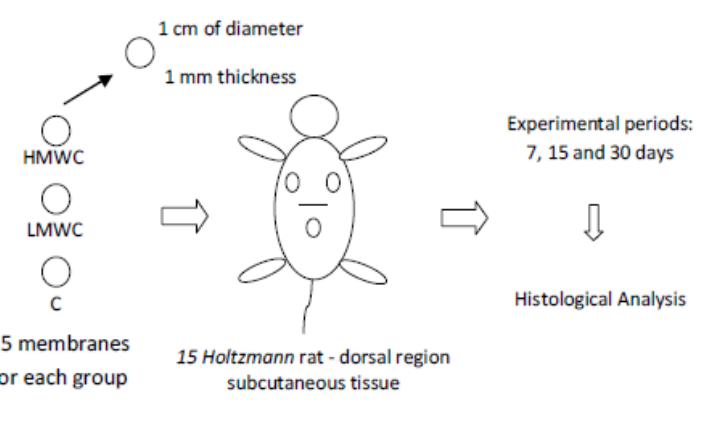
Figure 1. Study design schematic